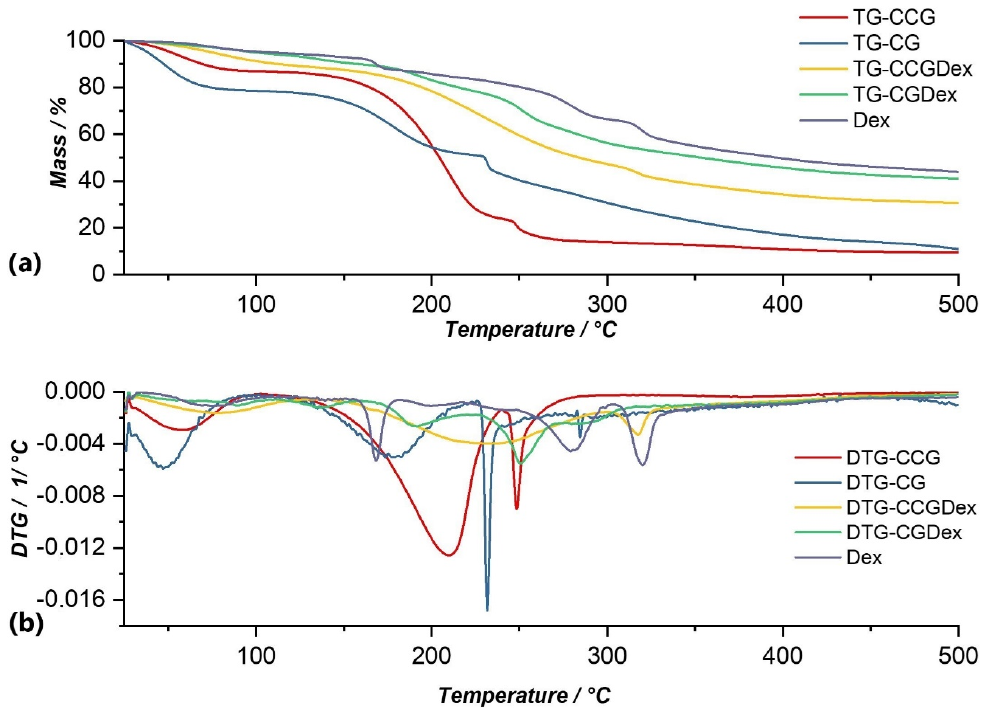
Figure 5. Comparison of TG ( a ) and DTG ( b ) curves of Dex with membranes in which this substance